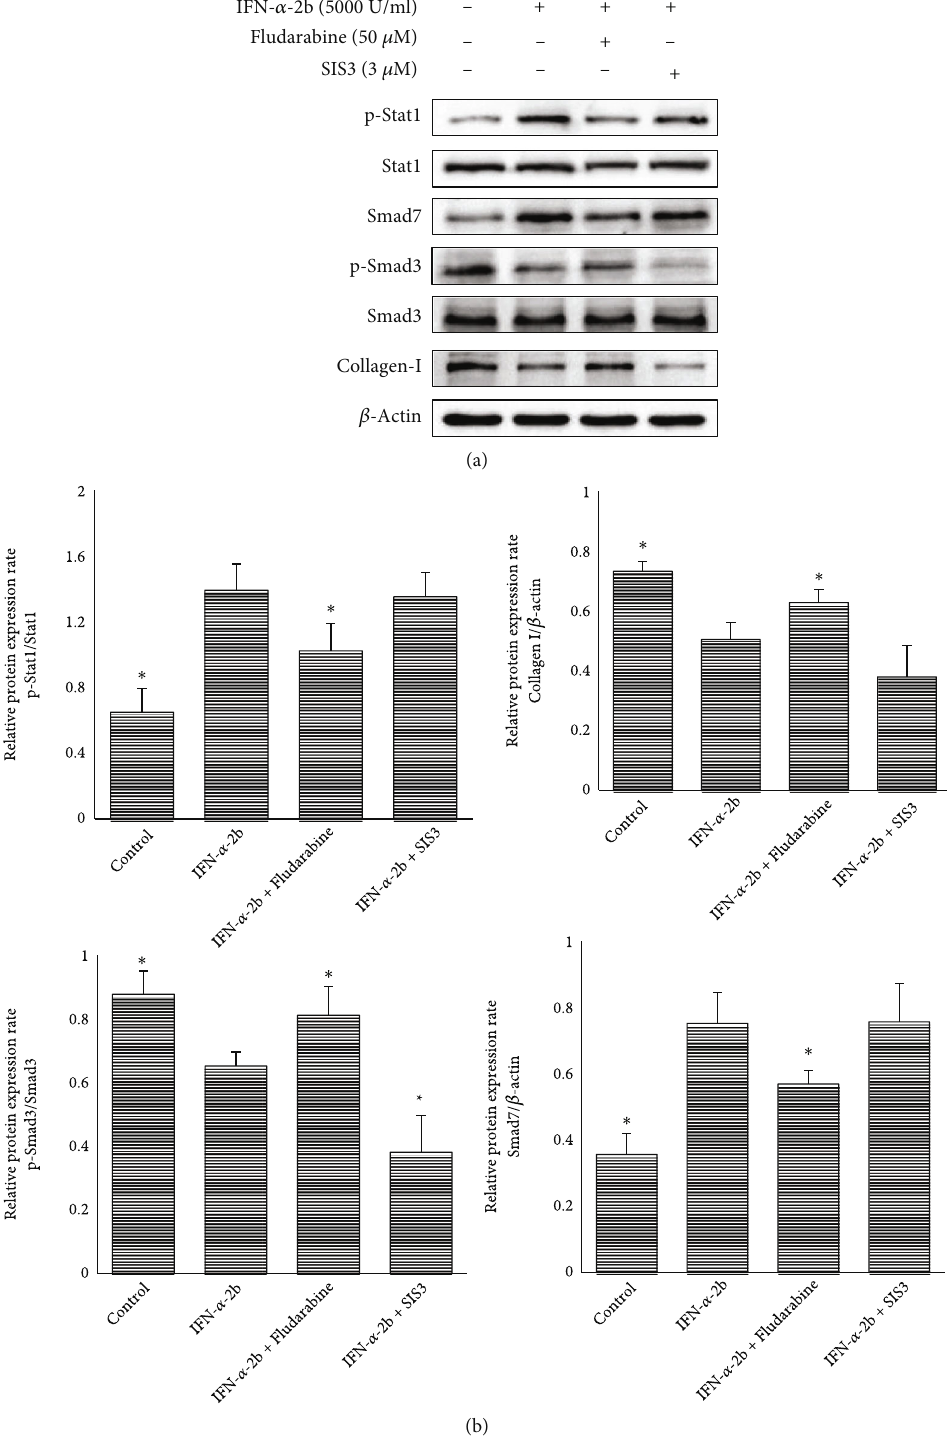
Figure 7: Crosstalk between STAT1/P21 and TGF β /Smad signaling pathways. (a) Western blotting showed the expression levels of p-Stat1, Smad7, p-Smad3, and collagen I in di ff erent groups. (b) The analysis results showed that IFN- α -2b signi fi cantly reduced the relative expression levels of p-Smad3 and collagen I, while increasing the relative expression levels of p-STAT1 and Smad7. Within the fl udarabine prestimulation group, the e ff ect trend was partially reversed. Compared with the IFN- α -2b group, the change trend of p- Smad3 and collagen I was enhanced in the SIS3 prestimulation group, but only the former had statistical signi fi cance, while p-STAT1 and Smad7 had no signi fi cant change. The histogram shows the results of three repeated detections of the gray value of the Western blot band. ∗ Compared with the IFN- α -2b group, P < 0 : 05 ( n = 3